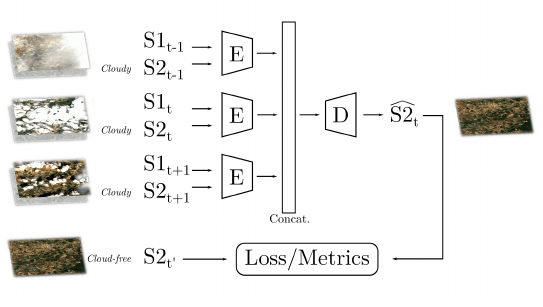
Figure 6. MSOP unet network. ( S 1 t − 1 , S 2 t − 1 ) , ( S 1 t , S 2 t ) and ( S 1 t +1 , S 2 t +1 ) denotes the input pairs of optical and SAR images. S 2 t (cid:48) denotes the reference image used to compute the loss (during training) and the metrics (at inference time from test data) from the reconstructed optical image (cid:100) S 2 t